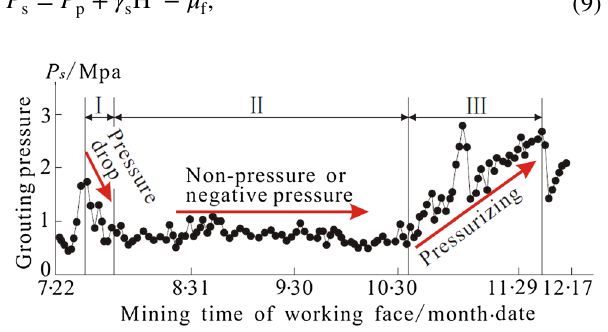
Fig. 6 Changes of grouting